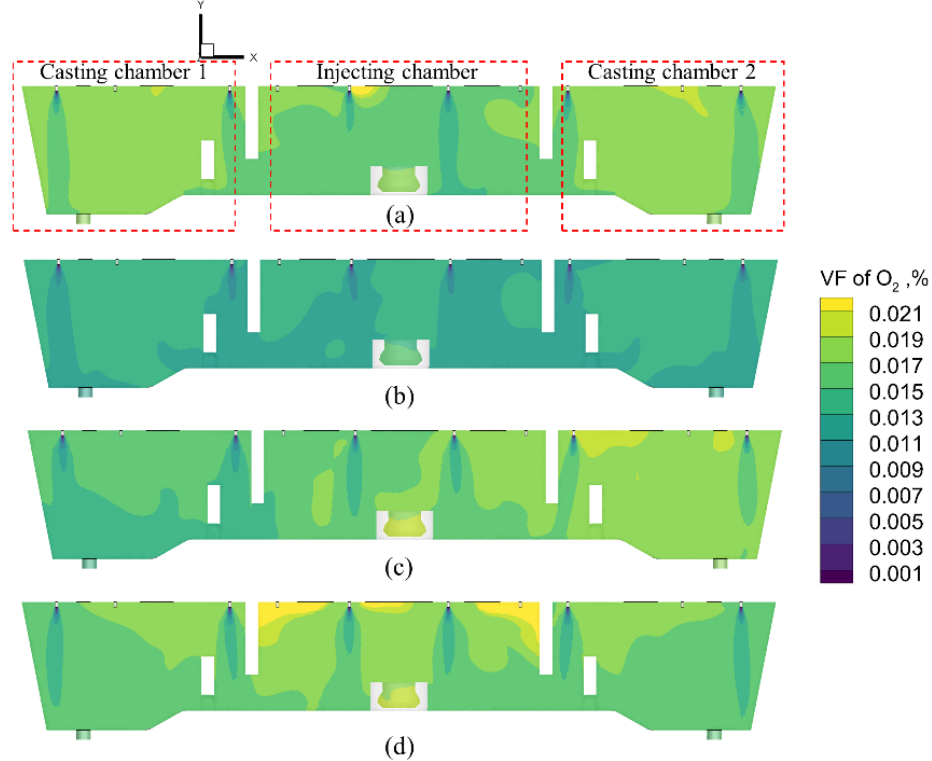
Figure 6. Contour of oxygen volume fraction at z = 0 m section, ( a ) for Scheme 1, ( b ) Scheme 2, ( c ) Scheme 3, ( d ) and Scheme 4.